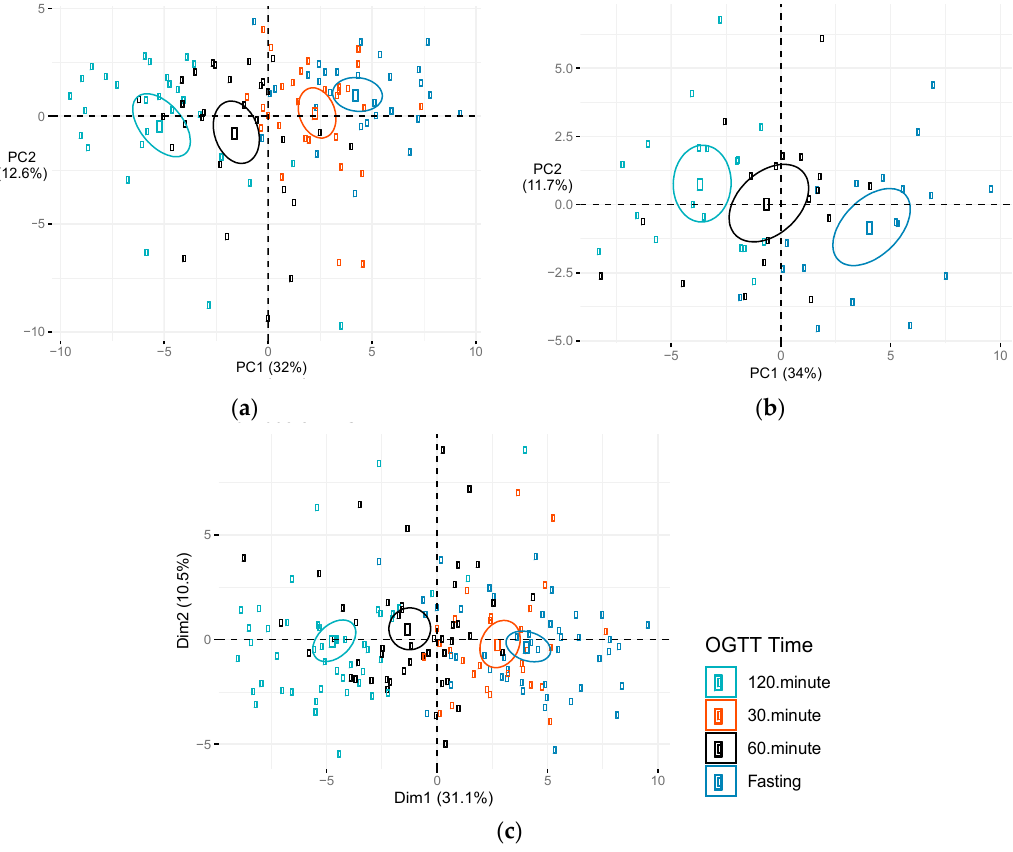
Figure 3. Score plot of principal component (PC) 1 versus PC2 by OGTT time. Metabolite levels during an OGTT among PEARLS participants: ( a ) During early pregnancy (n = 29), ( b ) mid-pregnancy (n = 18), and ( c ) combination of OGTTs conducted during early and mid-pregnancy. Figures depict plots of first two components. Dim1 represents PC1 and dim2 represents PC2. Percentage of variation in metabolite levels during an OGTT explained by each PC is presented in parentheses. Ellipses represent 95% confidence ellipses by OGTT time. Abbreviations: Dim, dimension; OGTT, oral glucose tolerance test; PC, principal component.